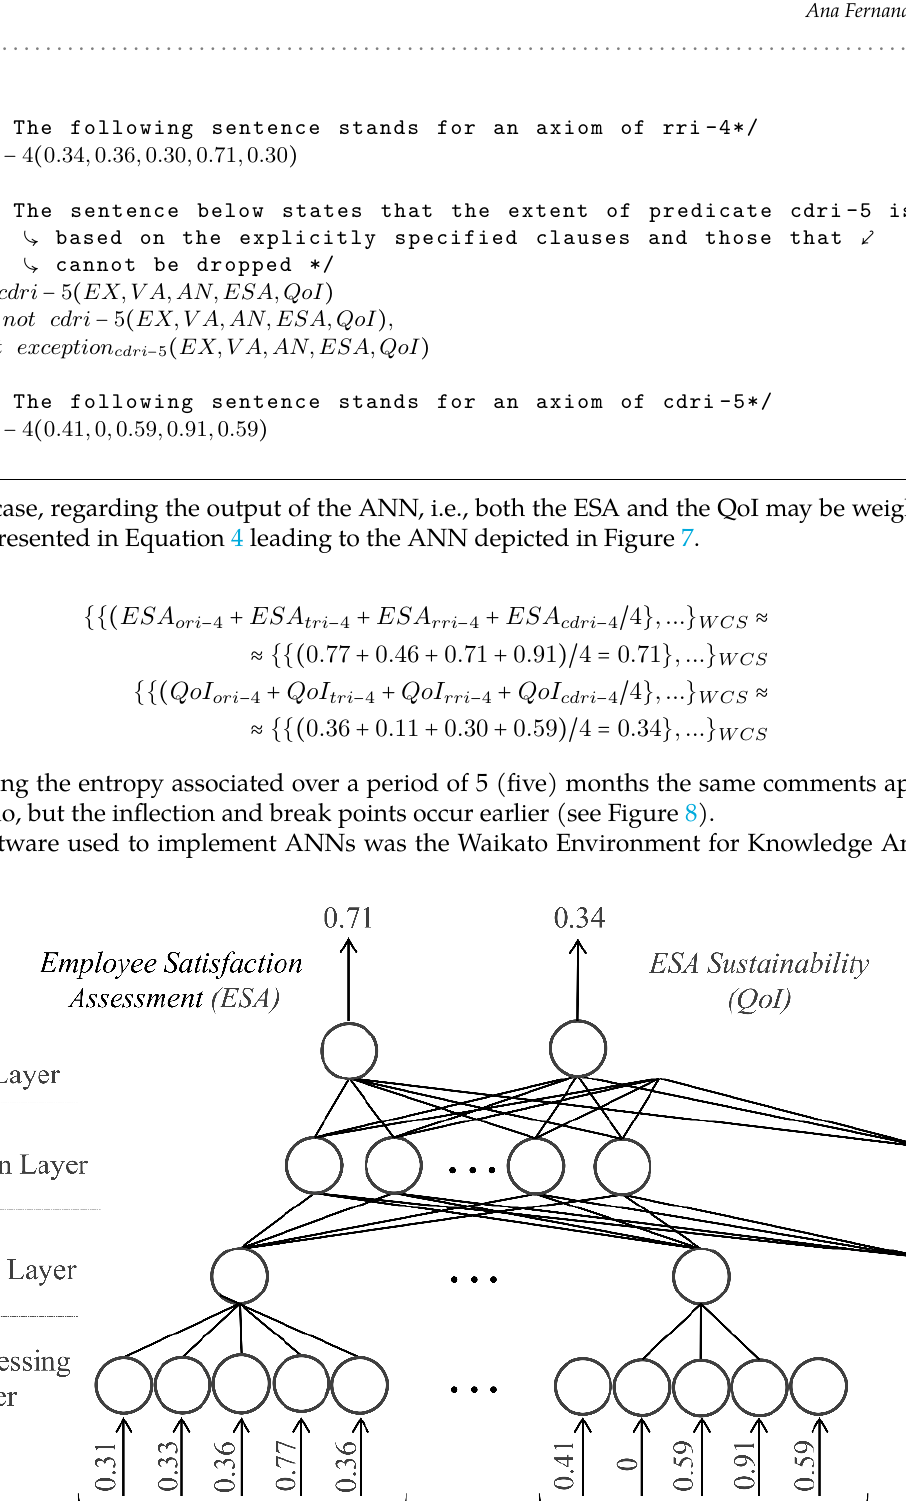
ParadigmPlus (2020)